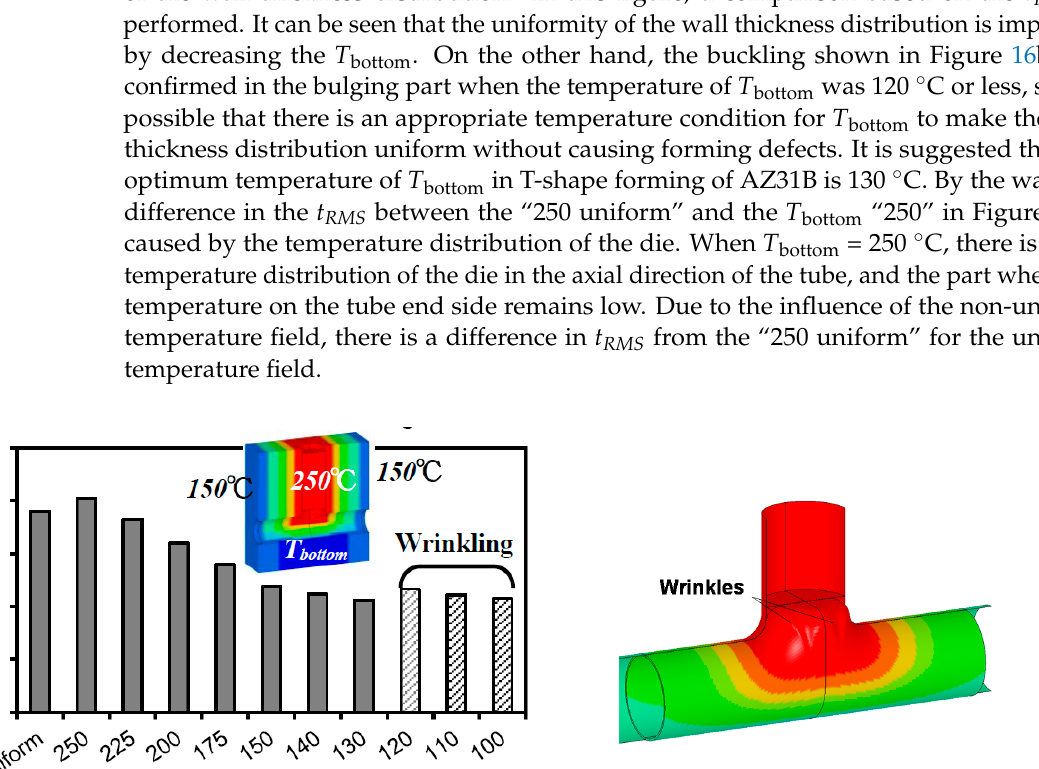
Figure 17. Optimum temperature conditions in T-shape forming for AZ31B magnesium alloy. 4.5. Wall Distribuntion in the Optimum Loading Path Under Optimum Temperature Distribution Figure 18 shows a comparison of the wall thickness distribution of the obtained formed product between the results of the conventional manual loading path and the op- timum loading path. From these figures, it can be seen that a formed product having a more uniform wall thickness distribution is obtained on both the bulging side and the bottom side. It is shown that it is possible to determine appropriate processing conditions for making the formed product uniform by performing the optimum process path in the hydroforming of the T-shaped sample of the AZ31B magnesium alloy tube.